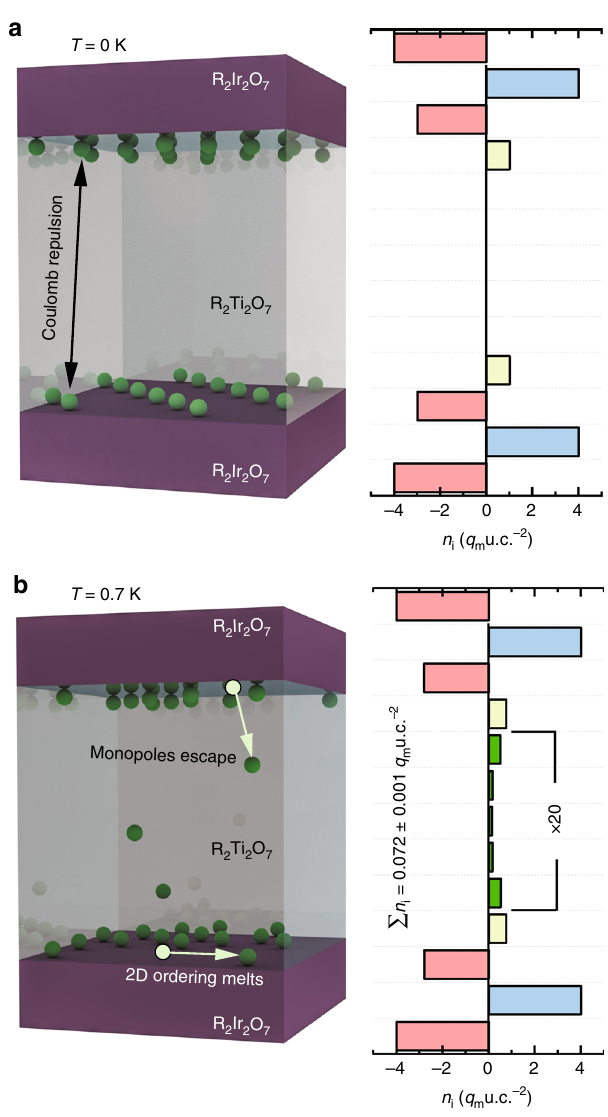
Fig. 6 Effects of long-ranged interaction on 2DMGs. Depth pro fi les and 3D illustrations of monopole distributions of a R 2 Ir 2 O 7 /R 2 Ti 2 O 7 /R 2 Ir 2 O 7 sandwich with dipolar interactions turned on. a In the ground state, the monopoles form a 2D stripe ordering at the boundary layers. b At 0.7 K, the 2D order melts and some monopoles enter the interior of the spin ice layers. The sheet density of escaped monopoles is shown. The Monte Carlo simulation is performed in a R 2 Ir 2 O 7 /R 2 Ti 2 O 7 /R 2 Ir 2 O 7 (001) sandwich and H ∕ J = loc eff